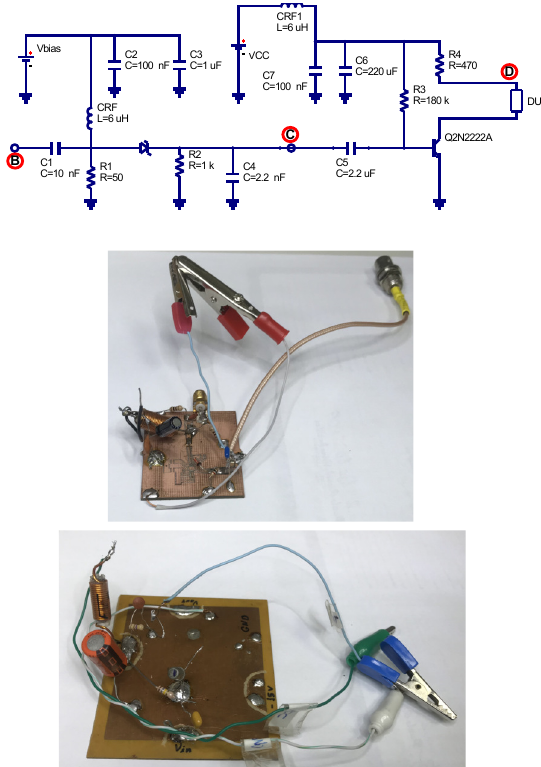
FIGURE 4. Schematic circuit (top) and respective envelope detector (center) and pulse amplifier (bottom) actual prototypes.